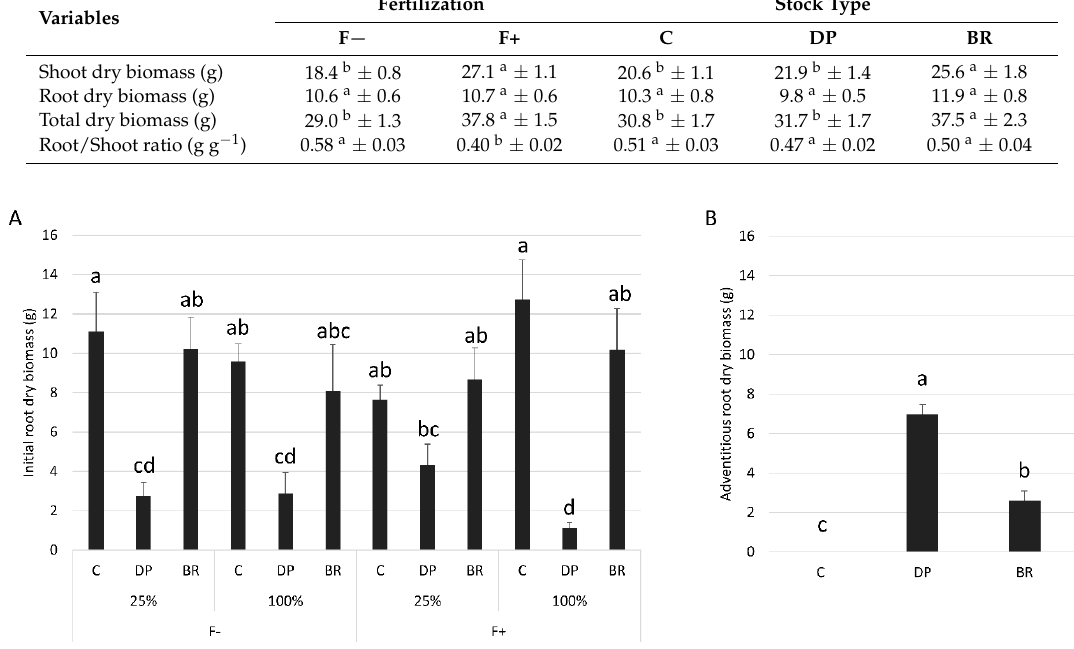
Figure 3. Mean dry biomass of black spruce ( A ) initial roots for each stock type × irrigation (25% or 100% field capacity) × fertilization (F − without and F+ with fertilization) treatments and ( B ) adventitious roots for each stock type. Bars with the same letter indicate a non-significant difference at P ≤ 0.05.